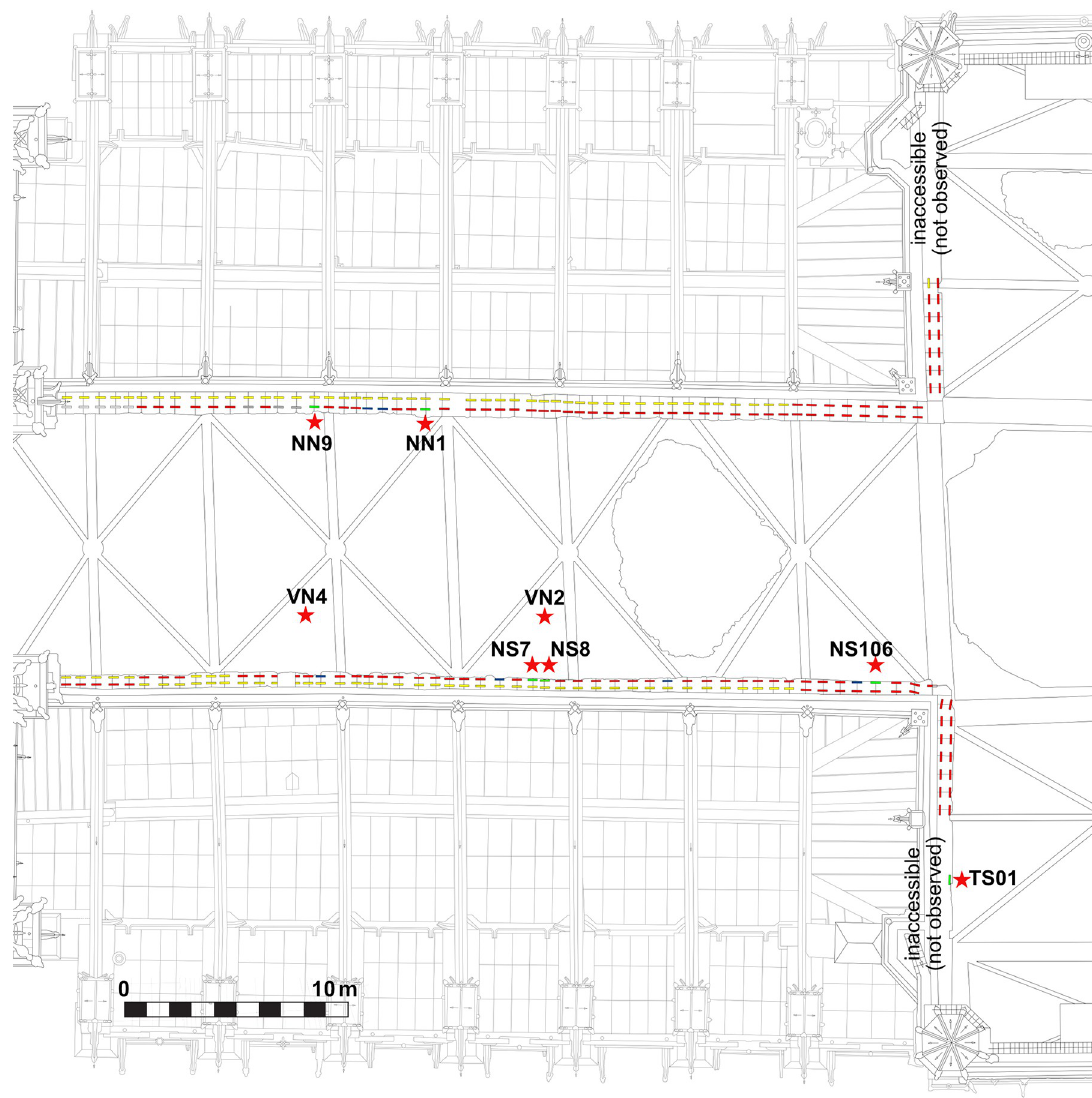
Fig 4. Map of the upper walls in the nave, showing the location of the staples and the sampling (Red = staples observed, Yellow, staples not measured (below provisional roof beams), blue = staples that fell with the fire, Green = staples sampled, Grey = staples formerly removed). Red stars: sampling